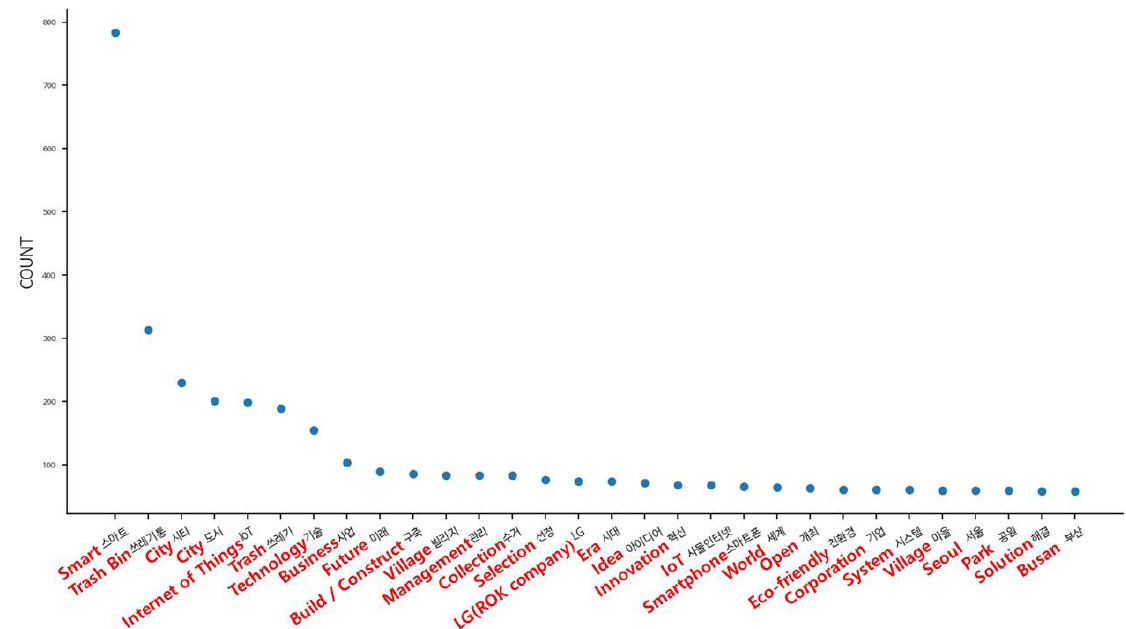
Figure 1. Plot for the Keyword “Smart Trash Bin”.